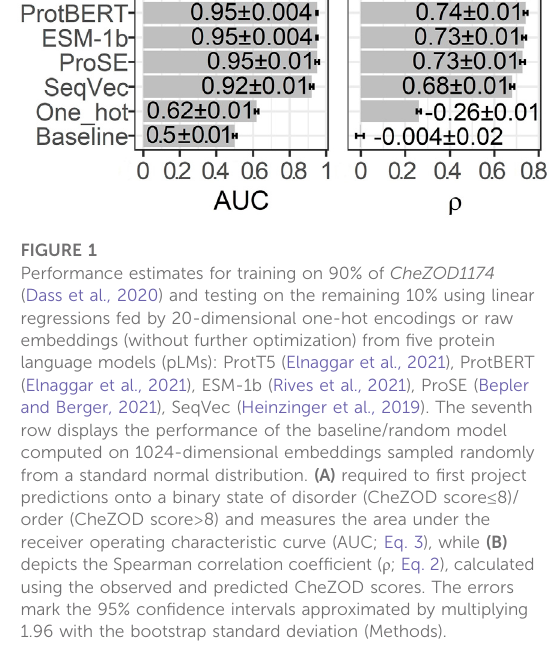
(below dashed line in Figure 3), and those using MSAs (above dashed line in Figure 3). When requiring a statistically signi fi cant difference at the 95% CI (±1.96 standard errors) for the ρ , our methods (SETH, ANN, LinReg and LogReg) signi fi cantly